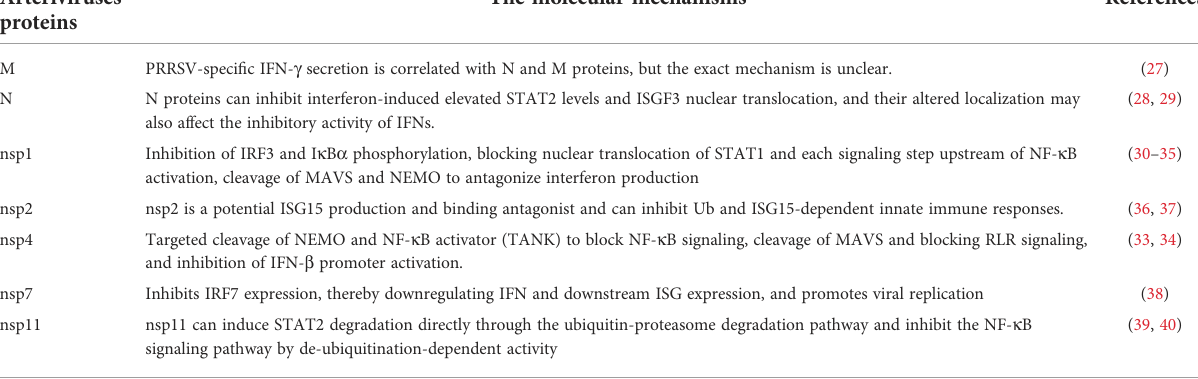
TABLE 1 Arteriviruses proteins inhibit IFN downstream signaling